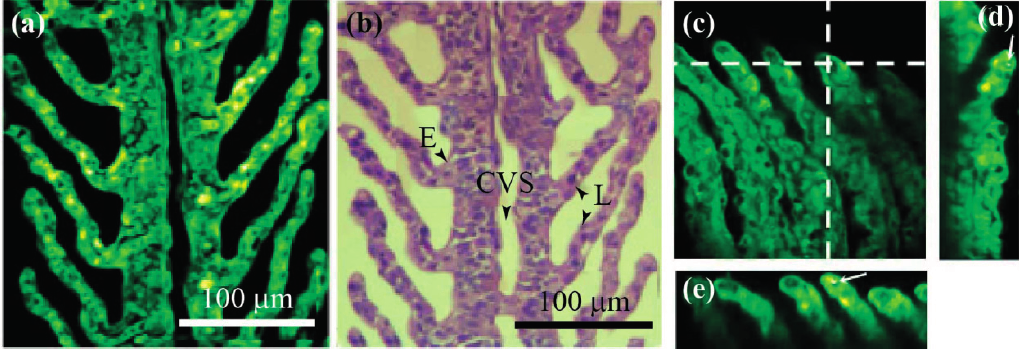
Figure 5. Coherent anti-Stokes Raman Scattering (CARS) image of gill